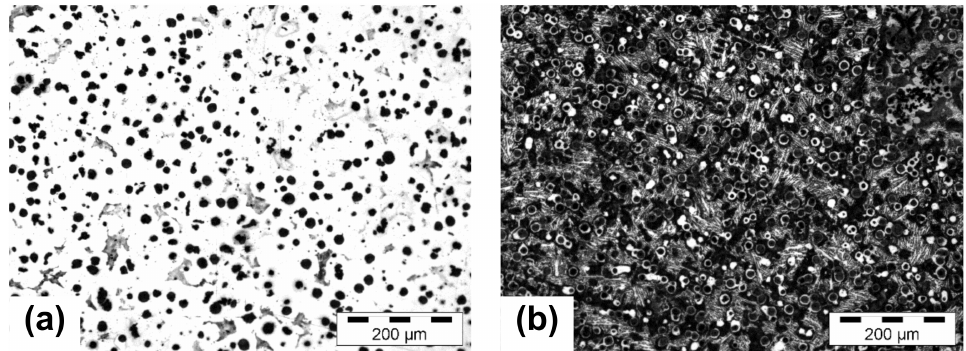
Figure 2. Structure of 4.5% Si ductile iron solidified in wedge casting in a sand mold ( a ) and a metal mold ( b ) with a 6 mm wall thickness